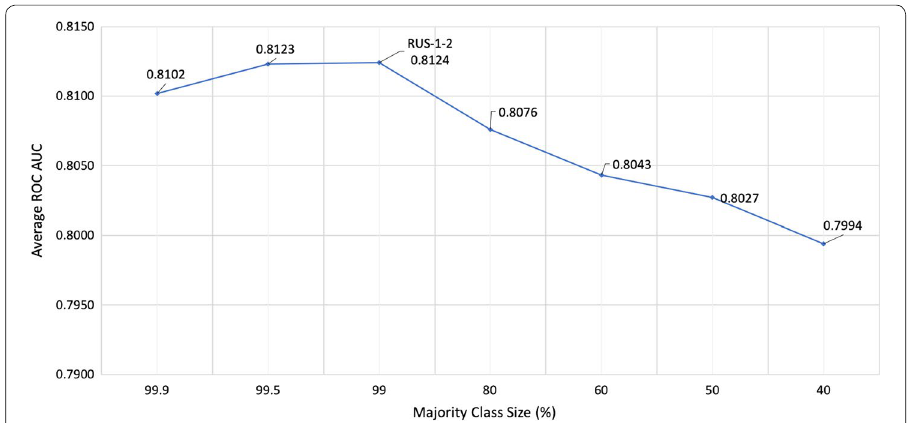
Fig. 1 RUS: majority class size vs average AUC (30 runs)